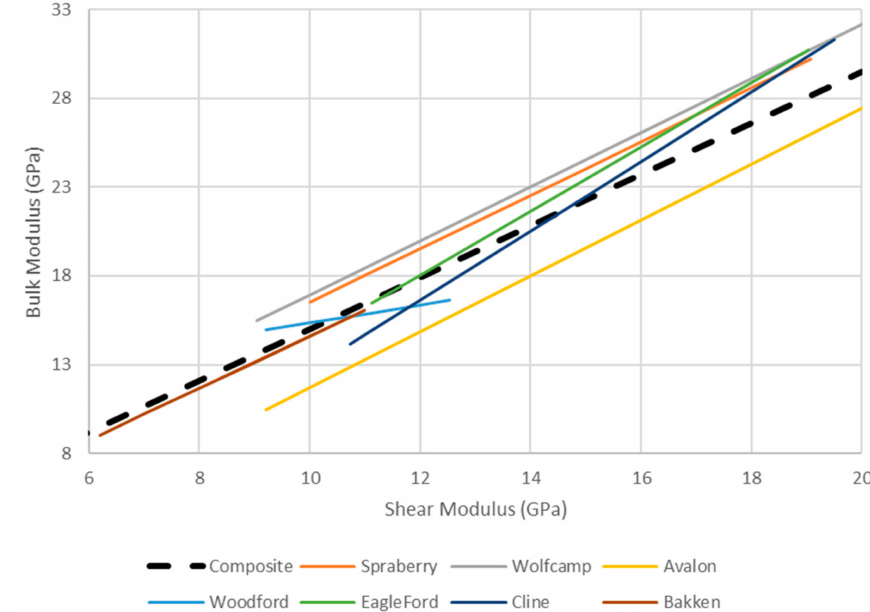
Figure 5. Formation specific dynamic bulk modulus ( k ) versus shear modulus ( µ ) trends for the seven shale reservoirs compared to the composite overall trend (dashed line) from Figure 4. The di ff erent formations have specific k versus µ trends displayed here (and given in Table 5) related to di ff ering lithological factors discussed below. All trends are statistically significant. The Woodford trend has an anomalous slope due to interbedding between organic shales (which have smaller moduli) and siliceous low TOC layers (which have greater moduli and a smaller k / µ ratio). The Avalon trend has an anomalously low intercept and k / µ ratio consistent with its anomalously high quartz